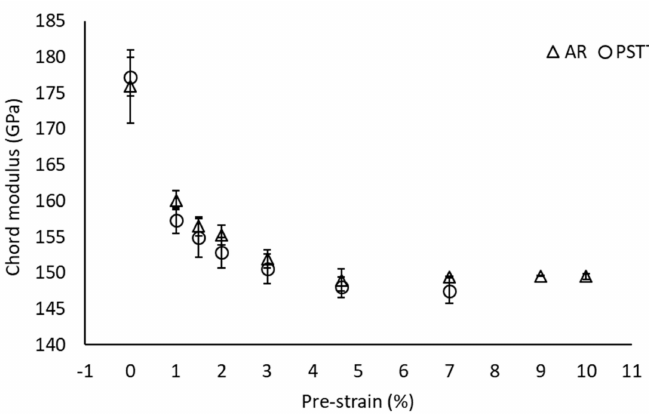
Figure 4. Chord modulus evolution in the AR material and PSTT material.